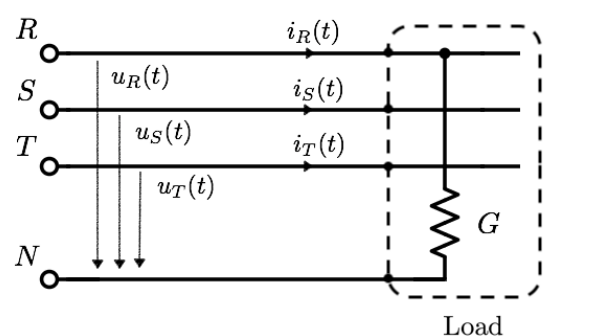
Figure 4. Unbalanced three-phase load supplied by a symmetrical souce in a four-wire